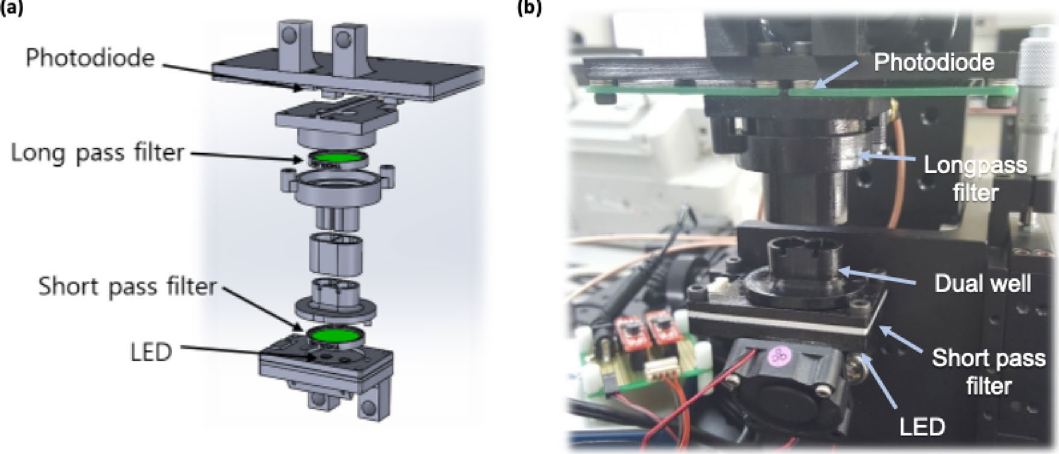
Figure 2. Fluorescence measurement system for PIFA reader ( a ) optical scheme of PIFA reader ( b ) photograph of equipment with dual wells to contain negative control and sample: fluorescence is measured while light is irradiated continuously. LED light from below, through short pass filter was used to excite the fluorescence and emitted light was detected by photodiode at the